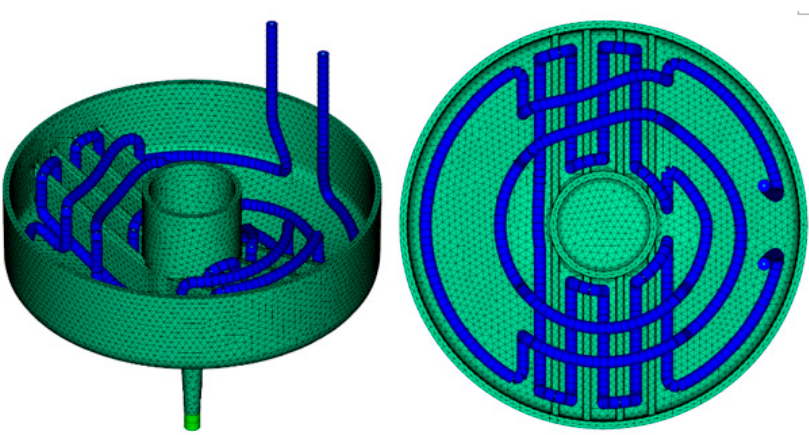
Figure 13. Mold part and final optimized configuration of the close-contour cooling system. Table 7. Initial and final values for the optimization parameters for the close-contour cooling sys- tem.